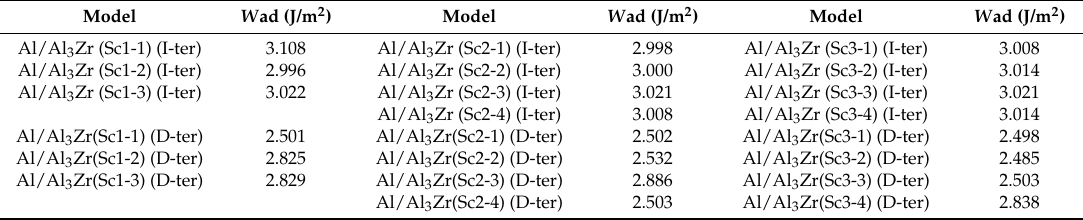
Table 6. Griffith separation work of interface models with different Sc-doped sites and Sc-doping ratios.